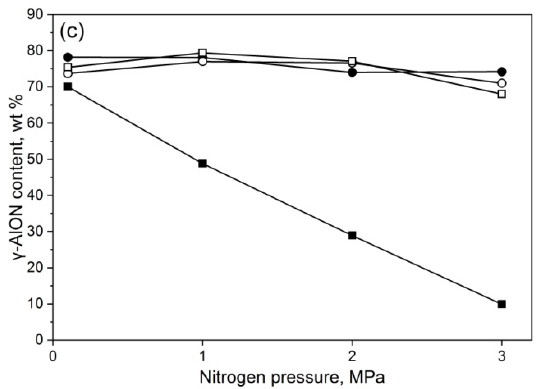
Figure 2. Aluminum oxynitride yield achieved by the means of SHS method from various aluminum metal powders: Al-7 ( ● ), Al-32 ( ○ ), Al-63 ( □ ), and Al-150 ( ■ ) and under varied nitrogen pressures for different substrates: ( a ) coarse EA-320, ( b ) medium EA-1200, ( c ) fine CT3000 alumina.